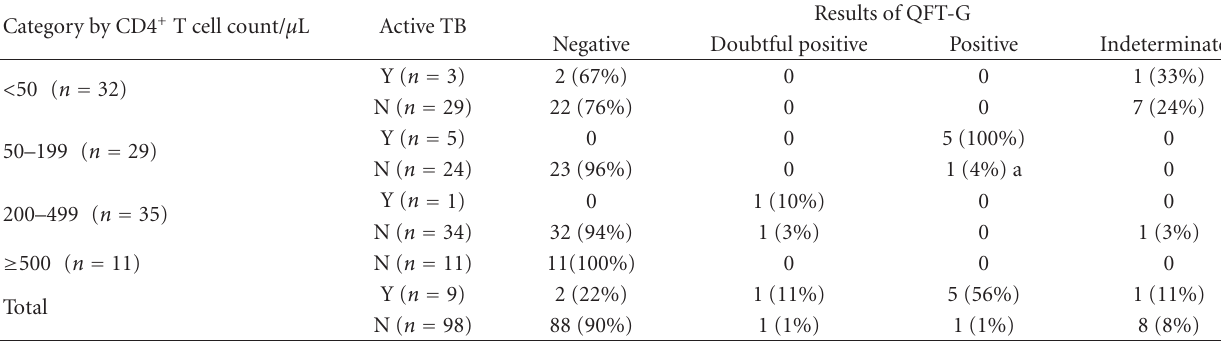
Table 3: Relationship between QFT-G results and CD4 + T cell